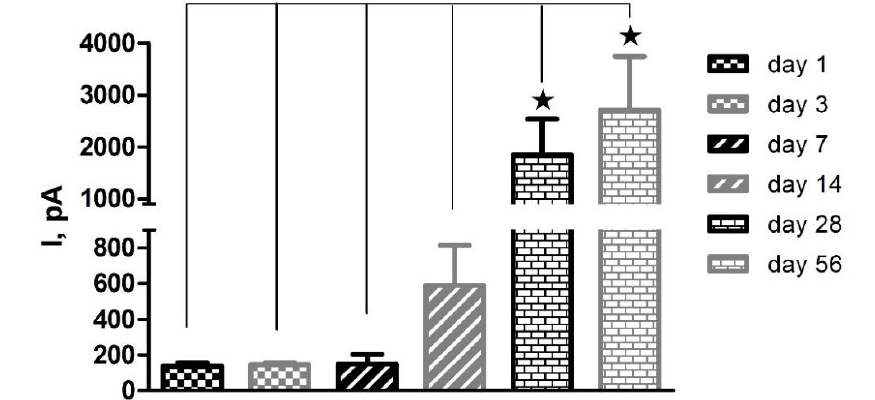
Figure 1. Comparison of the effects of repeated calibrations on the shelf life of platinum-poly- o -phenylenediamine (Pt-PPD) electrodes. Data represents maximum current recorded at 1000 μM ascorbic acid (AA) for Pt-PPD ( n = 4)